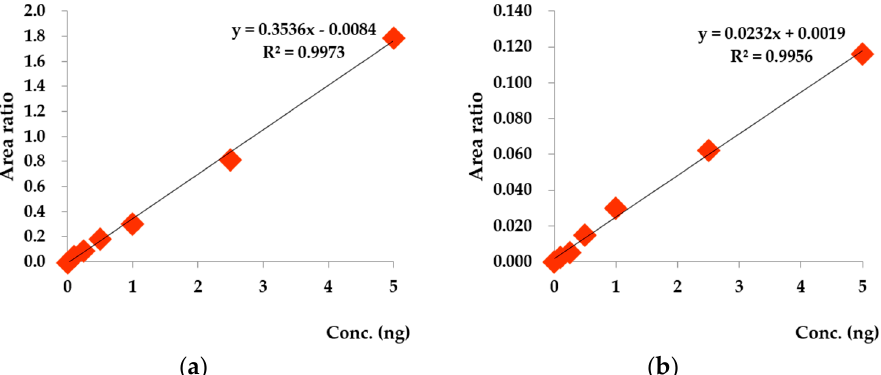
Figure 3. The calibration curve of measurement materials: ( a ) α -pinene calibration curve, ( b ) camphor calibration curve.